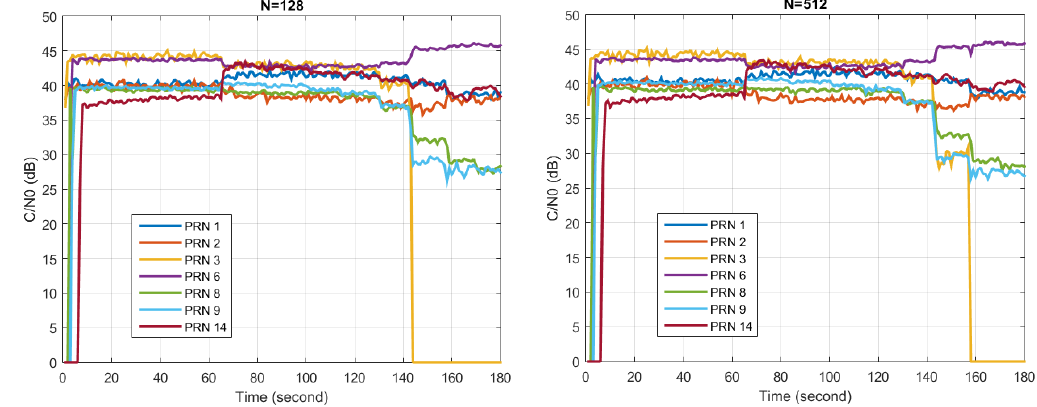
Figure 22. Performance of the SFAP nulling during Jamming Scenario 1. ( Left ) Results of C/N0 when N is 128; ( Right ) Results of C/N0 when N is 512.